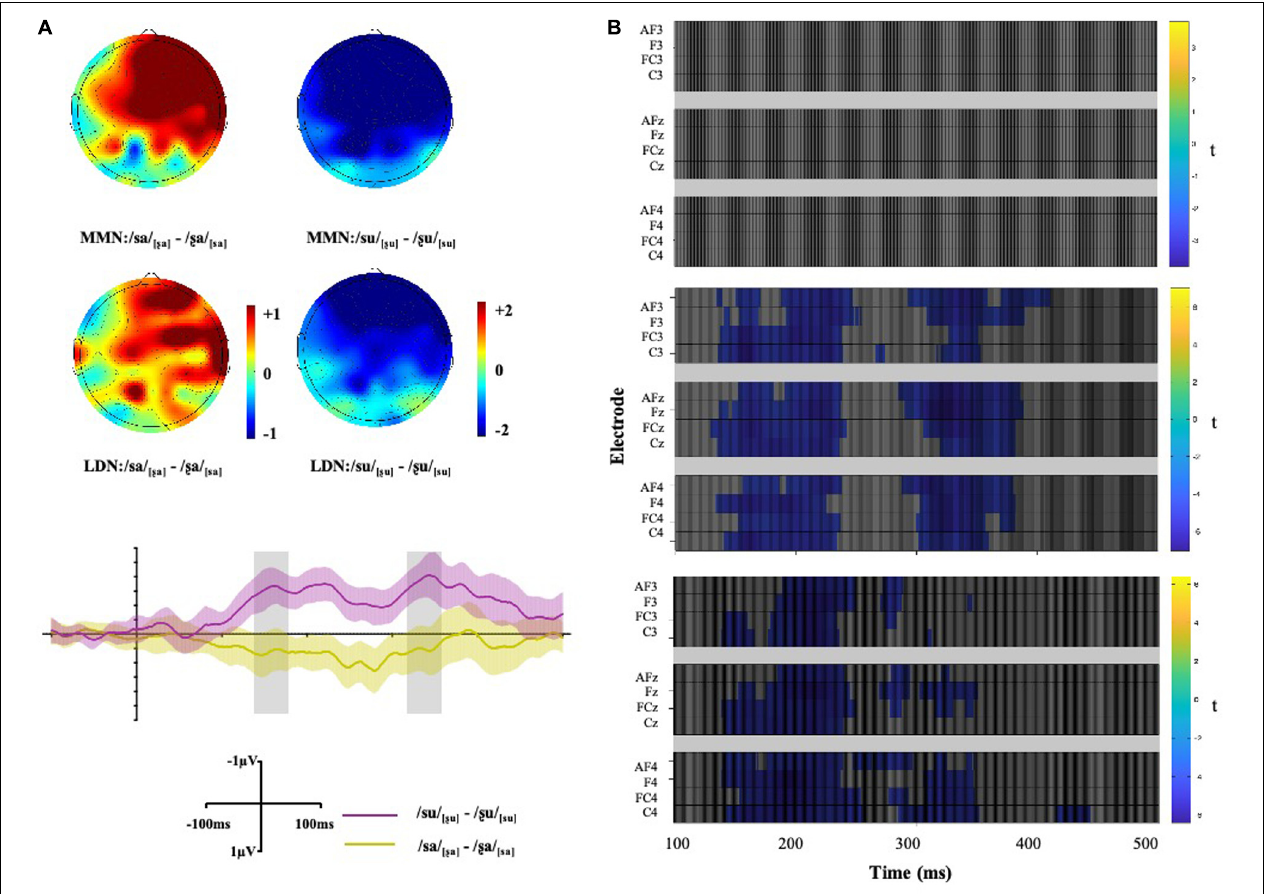
FIGURE 5 | (A) Maps display the topographic distribution of the mean amplitude difference between conditions in both the MMN (140–180 ms) and LDN (320–360 ms) analysis windows. Grand-average difference waveforms between conditions at Fz . Shade areas show 95% confidence intervals. (B) Within-subject t -tests between conditions at all selected electrodes after multiple comparison corrections using mass univariate ERP toolbox (Groppe et al., 2011). The difference is represented at each time point from 100 to 500 ms relative to the stimulus onset. Difference between /sa/ [ a ] ∼ / ù a/ [ sa ] (top); difference between /su/ [ u ] ∼ / ù u/ [ su ] (middle); difference between (/su/ [ u ] - / ù u/ [ su ] ) and (/sa/ [ a ] - / ù a/ [ sa ] ) (bottom).